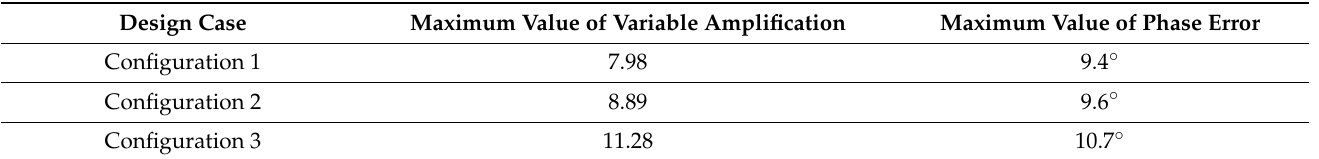
Table 4. Maximum values of the variable amplifiers and maximum values of phase error for each configuration. Design